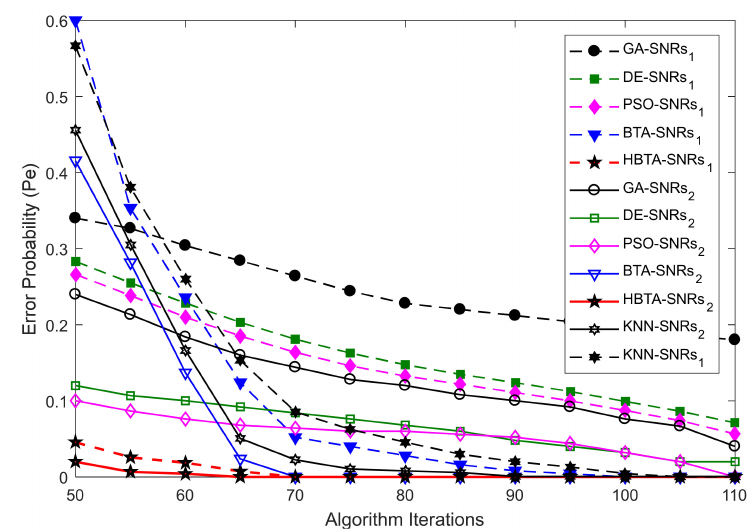
Figure 4. Error probability vs. iterations in the presence of AY-AYC users with SNRs 1 ( − 9.5 dB) and SNRs 2 ( − 0.5